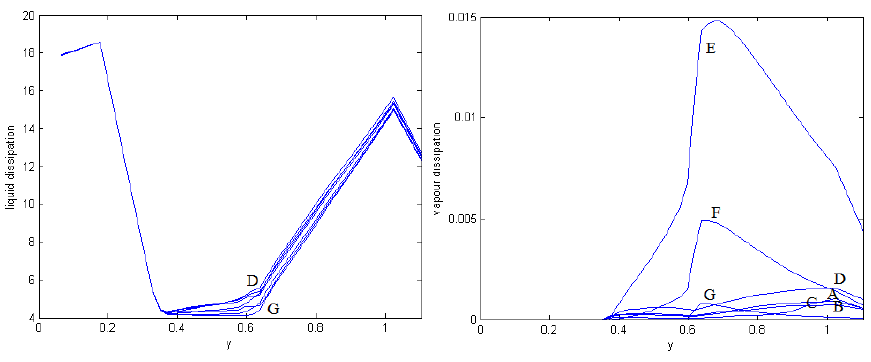
Figure 9. Viscous energy dissipation.